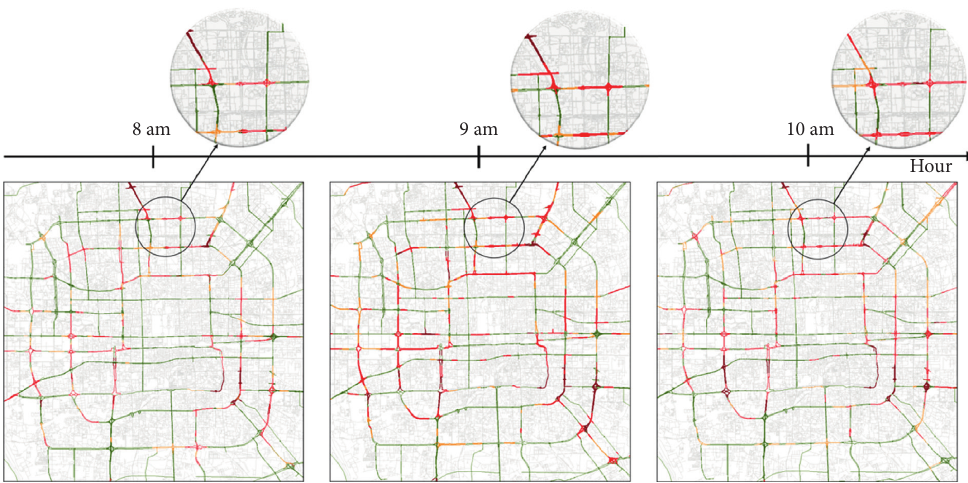
Figure 20: The pollutant concentration of the road network at 7am, 8am and 9am the peak of